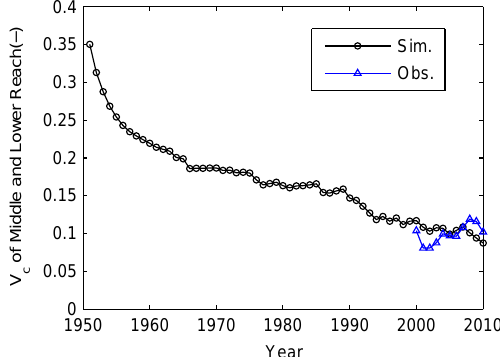
Figure 7. Vegetation cover ( V c ) of the lower reach of the Tarim River.